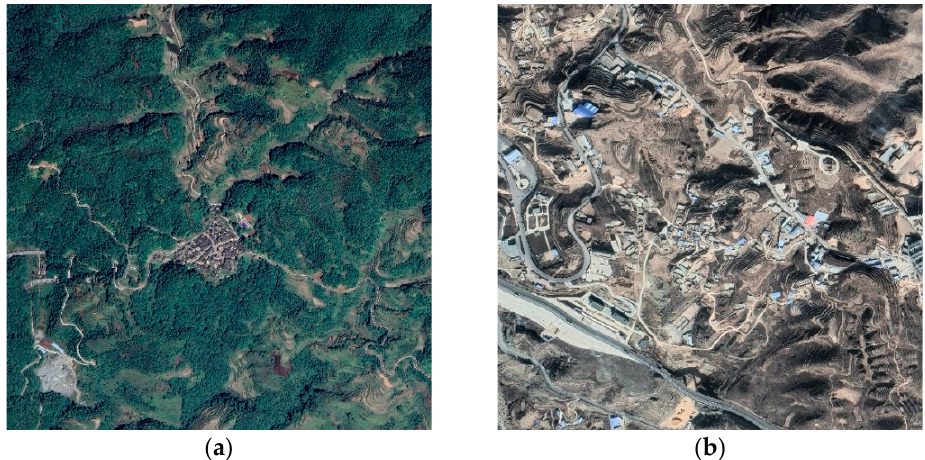
Figure 3. Remote sensing images of hillside pattern settlement. ( a ) Zeli settlement in Qiandongnan of the Guizhou Province; ( b ) Zhangzhuang settlement in the Shaanxi Province.